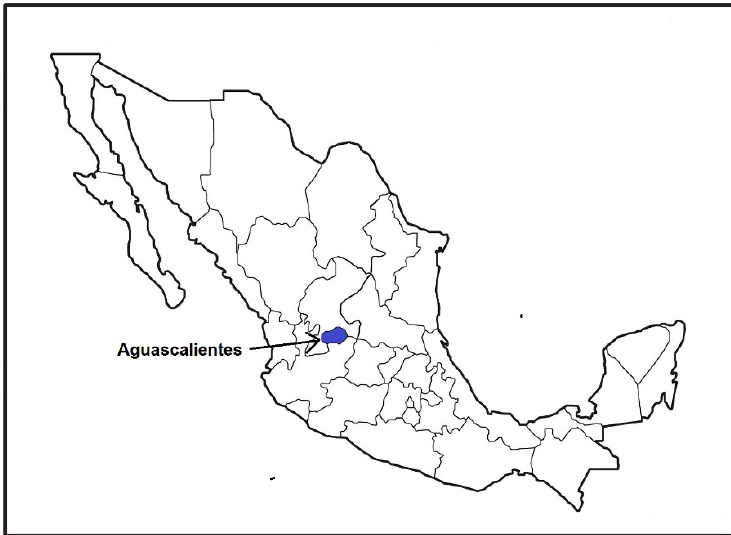
Figure 1. Map of Aguascalientes State.